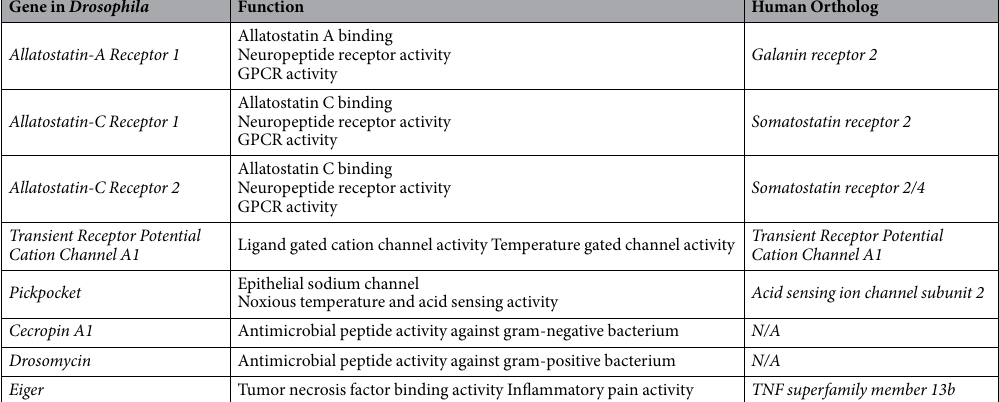
Table 1. Immune and nociceptive related genes in Drosophila melanogaster probed in this study with their corresponding functions and human